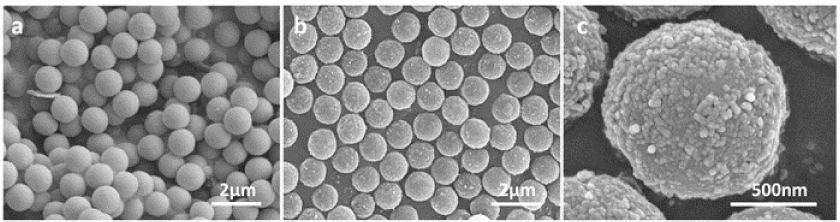
Figure 2. SEM images of microspheres. ( a ) PGMA microspheres. ( b ) Carboxyl magnetic microspheres. ( c ) The close-up of carboxyl magnetic microspheres.